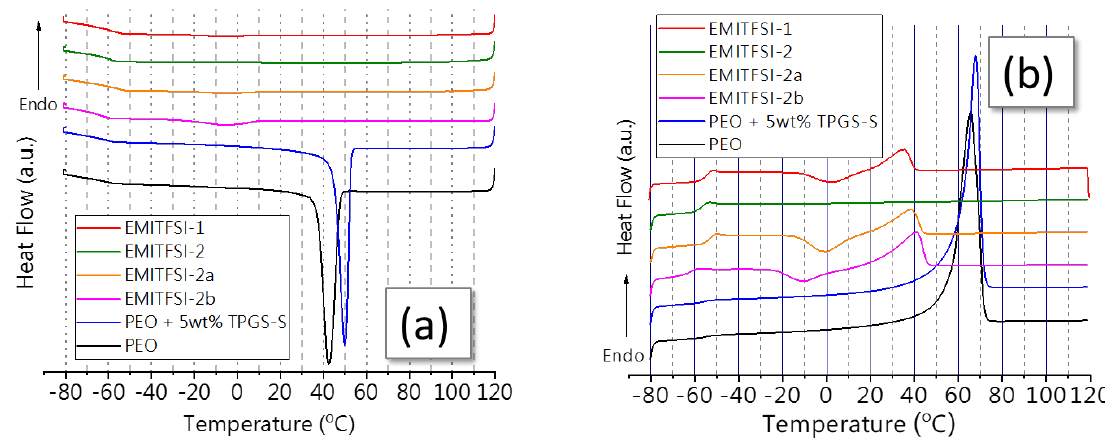
Figure 2. DSC of the first cooling scan ( a ) and of the second heating scan ( b ) of the four electrolytes EMITFSI-1, EMITFSI-2, EMITFSI-2a, and EMITFSI-2b, together with those of PEO and PEO melt compounded with 5 wt % of TPGS-S. Table 2. Physicochemical characterization of PEO, PEO + 5 wt % TPGS-S, and the electrolytes. Transition temperatures T g , T c , and T m , as measured by DSC, a result of the self-creep test at 90 ◦ C and ionic conductivity ( σ